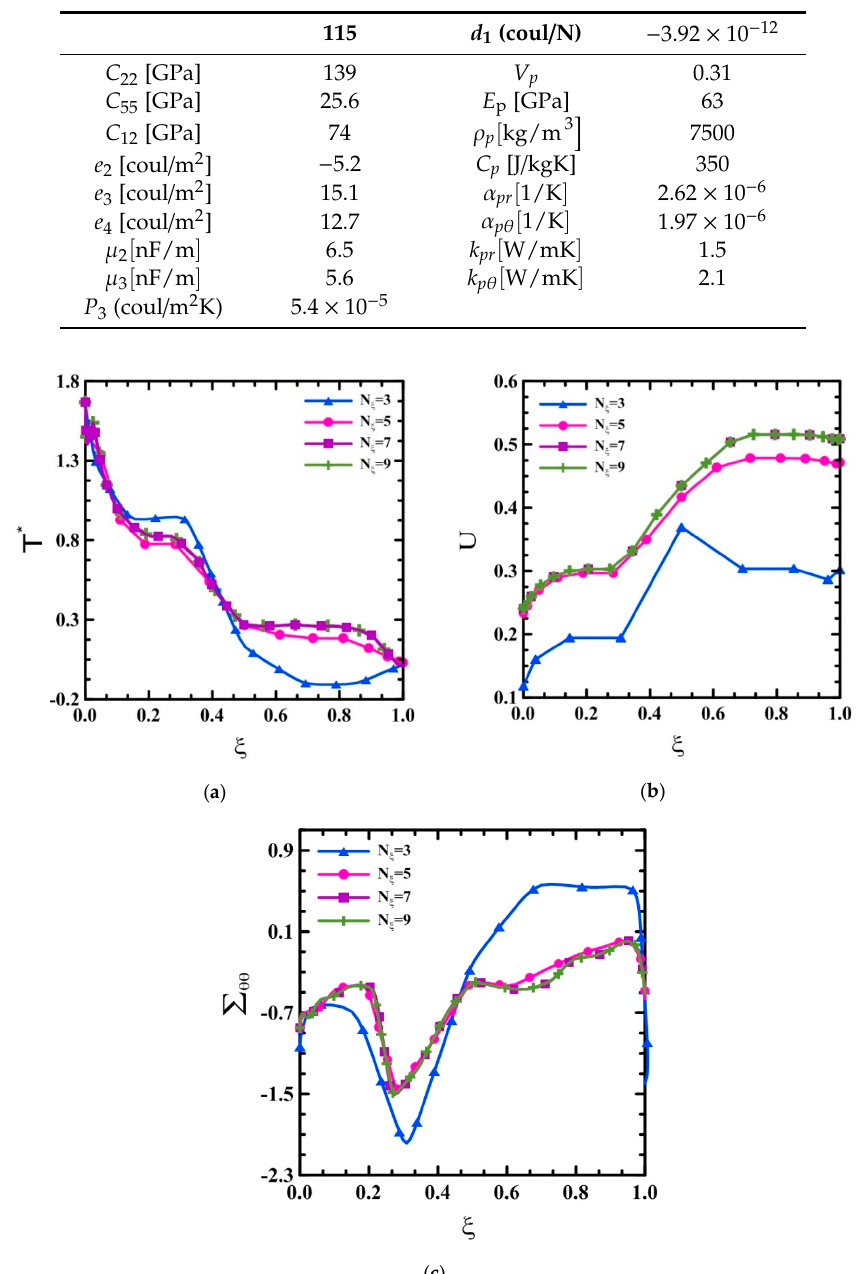
Figure 2. ( a – c ): Parametric analysis of the thermoelastic field variables vs. the number of grid points ( (cid:16) n = 1, h c / h p = 5, N θ = 11, N t = 300, θ 0 = 75 ◦ , θ = 0.5 θ 0 , ψ = 0.03, F 0 = 0.8, τ = 0.2